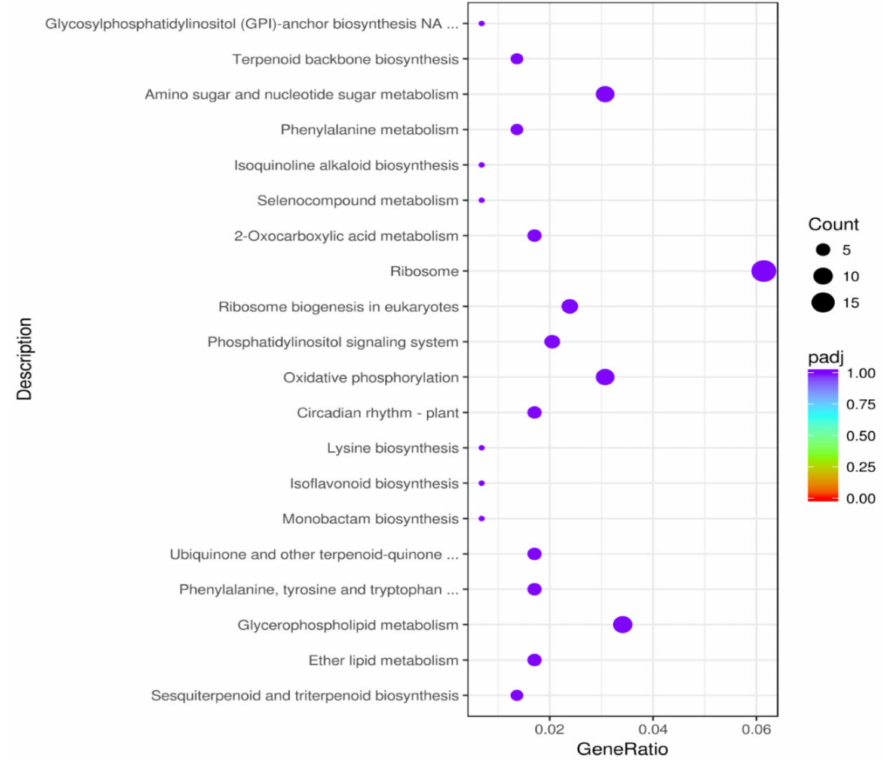
Figure 5. The scatter plot of top 20 KEGG pathways up-regulated in prostrate and bunch peanut. The x-axis represents the ratio of the number of differential genes annotated to the KEGG pathway to the total number of differential